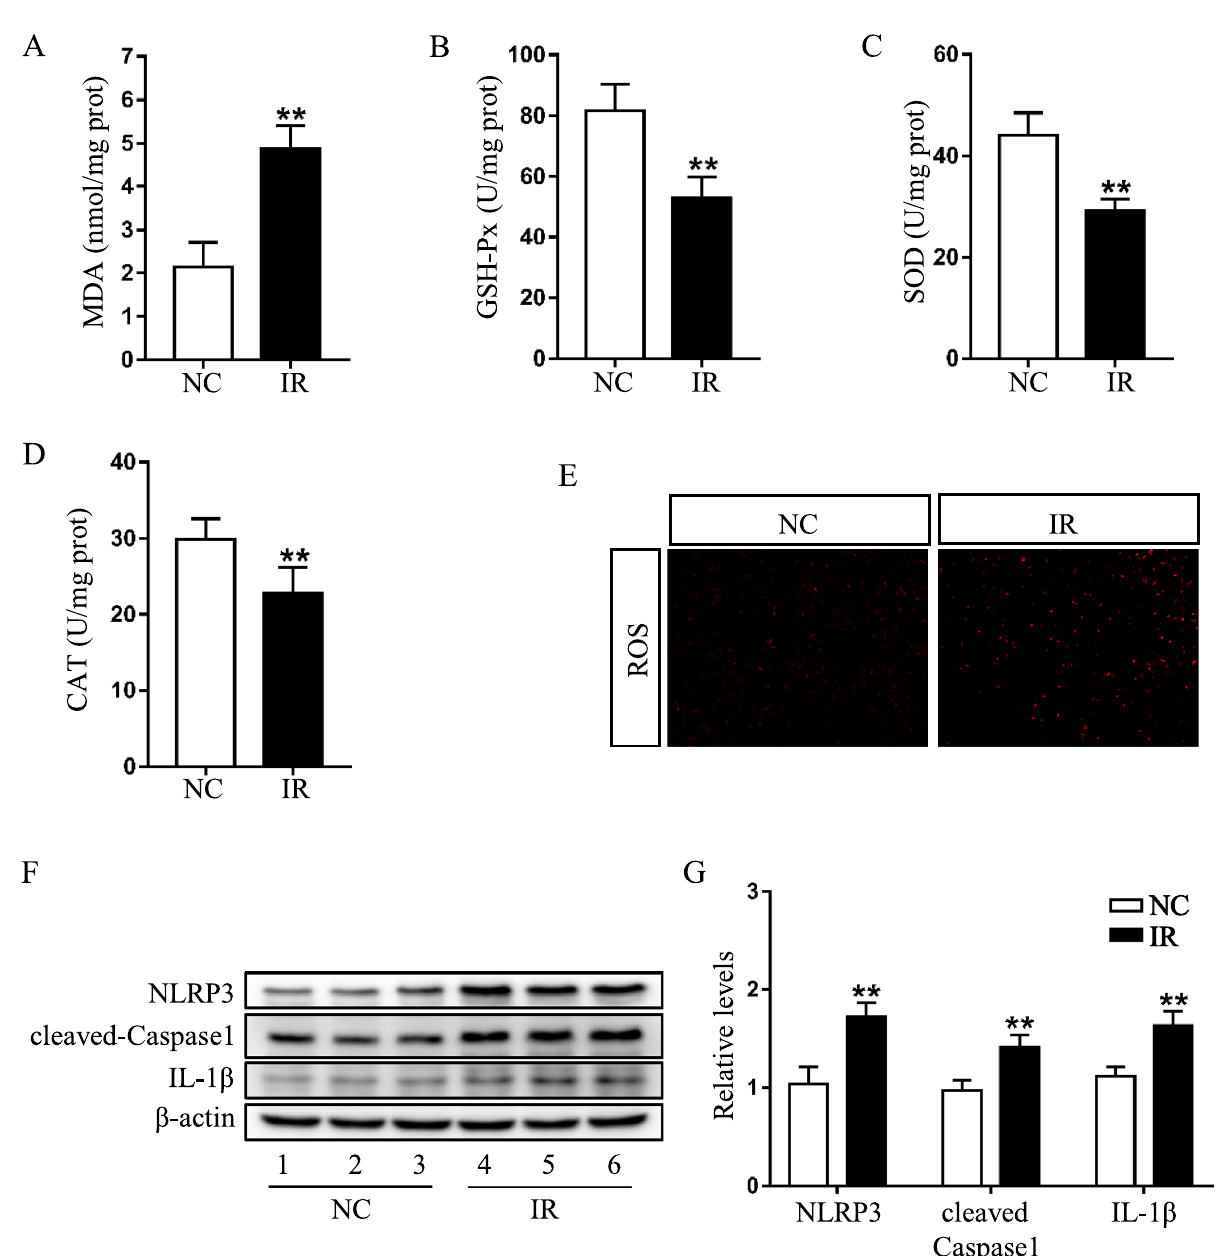
Figure 3. Irinotecan (IR) aggrandizes hepatic oxidative stress and NLRP3 inflammasome activity in mice. Effects of IR on hepatic ( A ) MDA, ( B ) GSH-Px, ( C ) SOD and ( D ) CAT content. Data are presented as mean ± SD (n = 8), ** P < 0.01 compared with normal control (NC) group. ( E ) Hepatic ROS level were determined by DHE staining. Red color is considered as ROS staining. ( F ) Western blot analysis of NLRP3, cleaved-Caspase1 and IL-1β protein levels in liver tissue. ( G ) Densitometric quantification of NLRP3, cleaved- Caspase1 and IL-1β. The blots were cut prior to hybridisation with indicated primary antibodies. Data are presented as mean ± SD (n = 6), ** P < 0.01 compared with NC